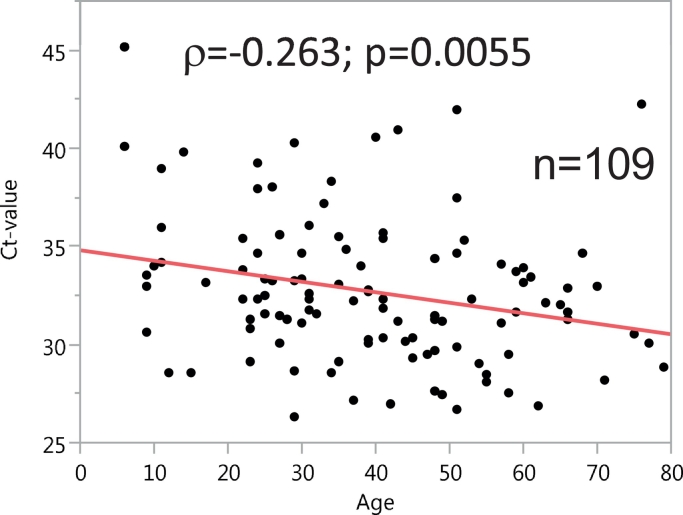
Correlation of the cycle threshold (ct) values of the Mansonella perstans specific real-time PCR for the detection of parasite DNA in blood with the age (in years) of the study participants.